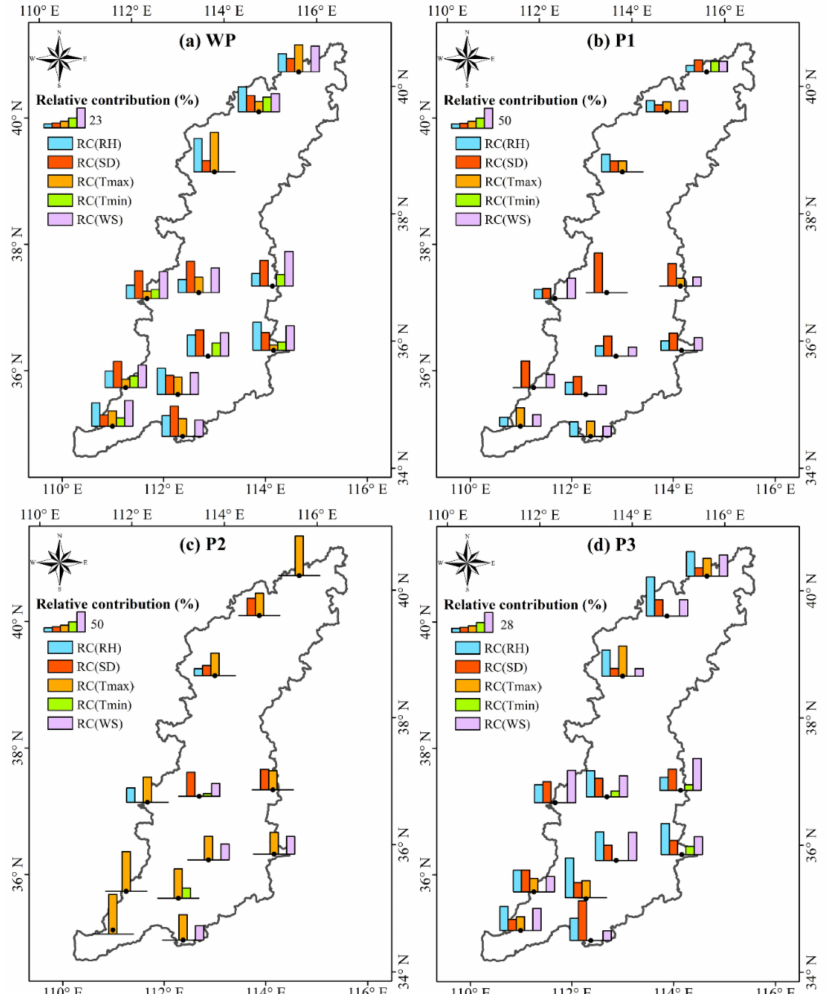
Figure 11. Relative contributions of the climatic driving factors to ETo during the whole study period and the three subperiods, ( a ) WP, ( b ) P1, ( c ) P2, and ( d ) P3 in the